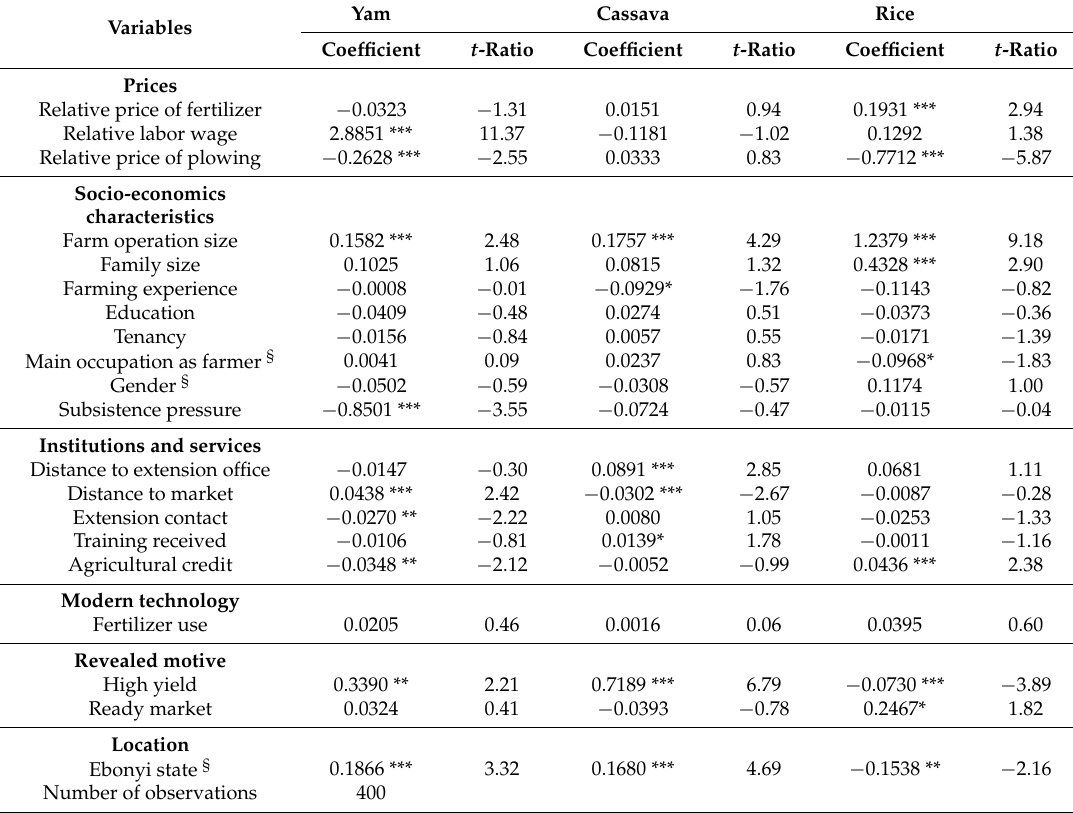
Table 4. Elasticity of factors influencing choice of crop diversity and